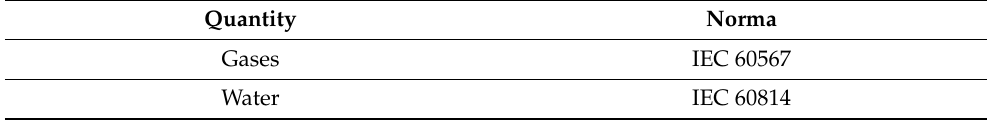
Table 19. Quantities and technical standards are used by a specialized